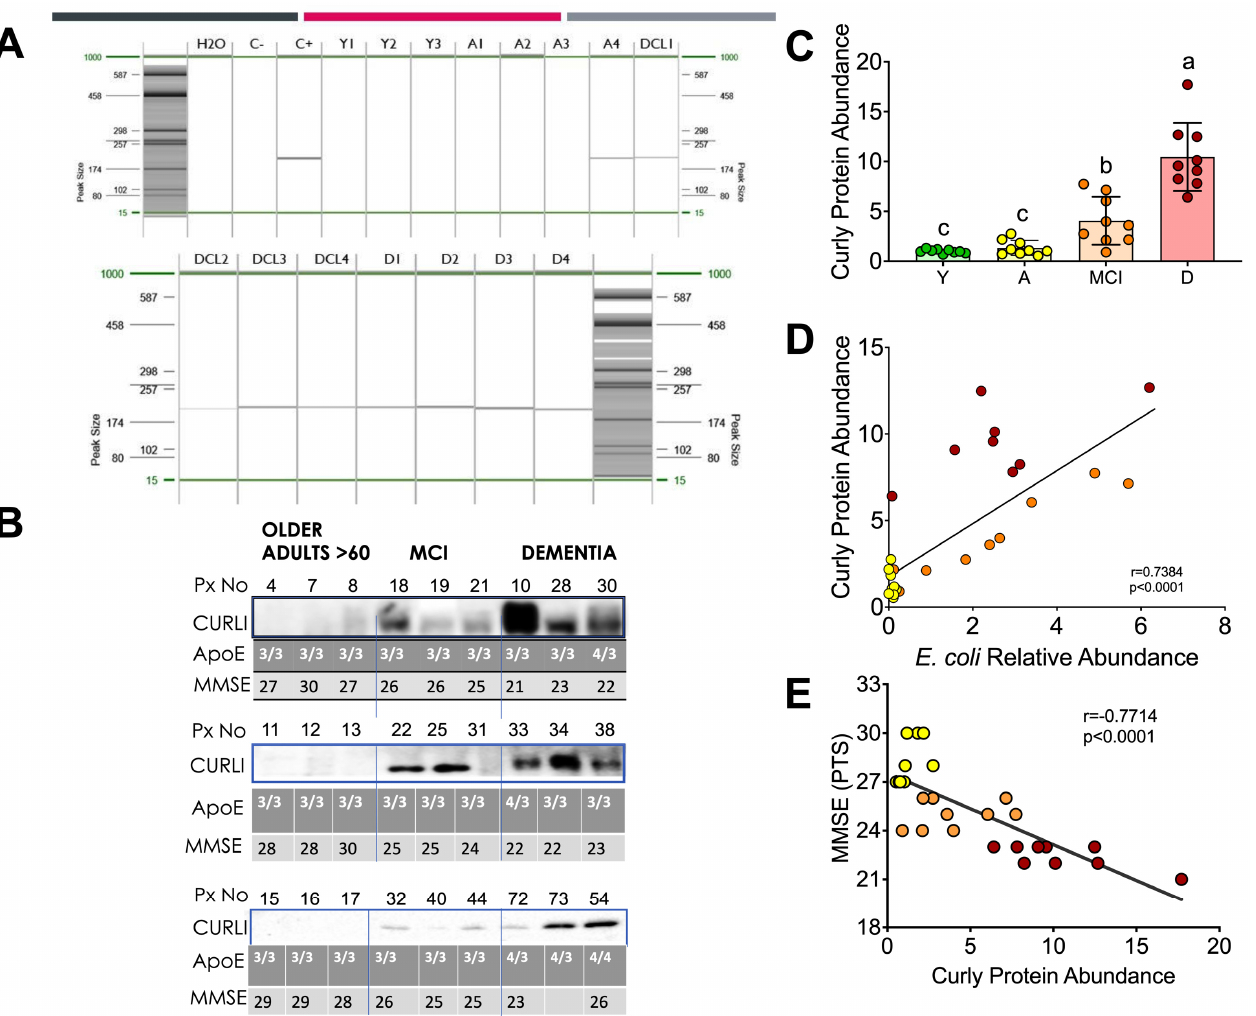
Figure 4. Association between the curli protein, polymorphism in ApoE and cognitive classification. PCR ( A ) and Western blot analysis of curli protein in human fecal samples, ApoE genotyping, and MMSE scoring ( B ). Densitometric analysis of curli protein in human fecal samples ( C ). Correlation analysis between the relative abundance of curli protein and Escherichia coli relative abundance ( D ) and the MMSE score ( E ). Raw data and mean are presented ± standard error. Y = young, A = aging, MCI = mild cognitive impairment, D = dementia, a > b > c, significance p < 0.05. Statistical significance was assessed by Spearman r. p <